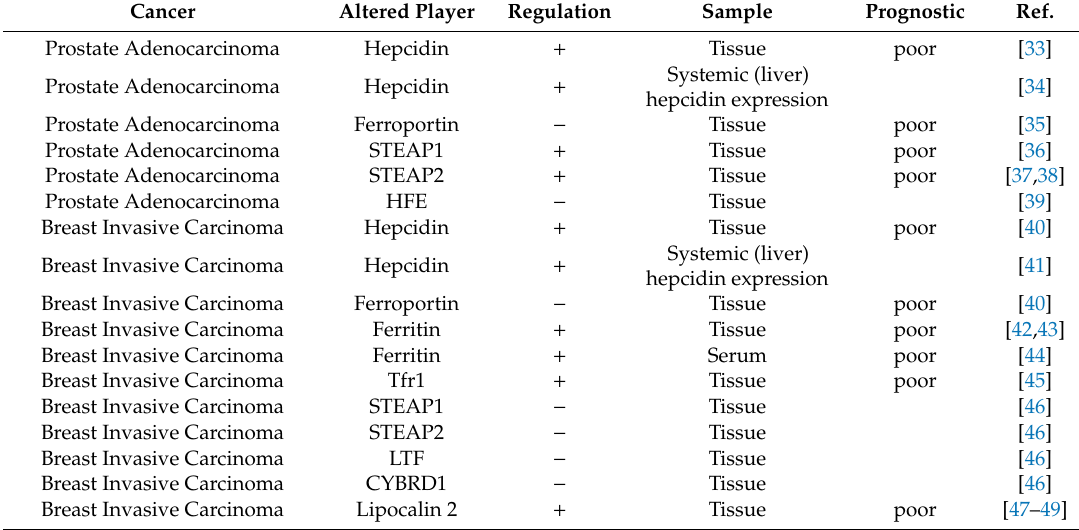
Table 1. Fe regulators and their roles in cancer ( + : upregulated; − : downregulated). Cancer Altered